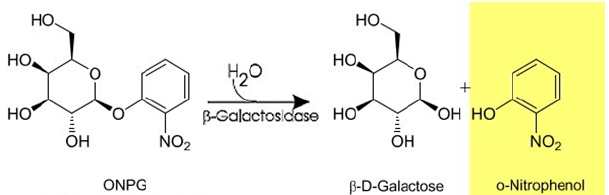
Figure 2. Enzymatic hydrolysis of O-nitrophenyl- β -D-galactopyranoside (ONPG) by β -galactosidase [20].